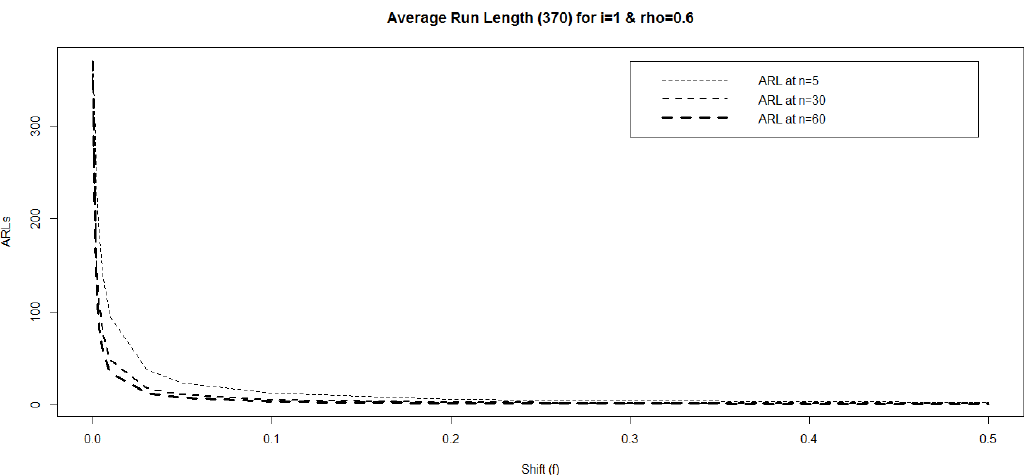
Figure 1. Trend of ARLs according to shift constant when 𝐴𝑅𝐿 0 = 370 , 𝑖 = 1 and 𝜌 = 0.6 with 𝑛 = 5, 30, 60 .